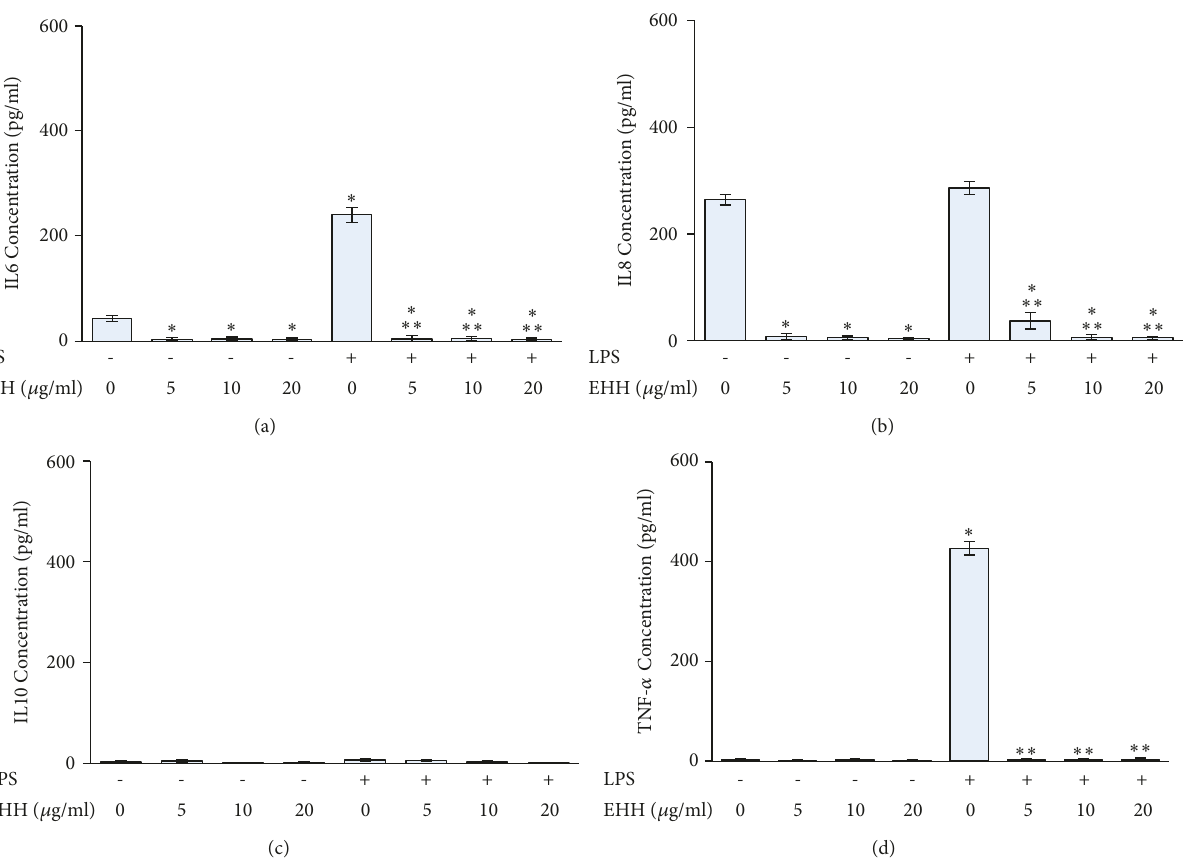
Figure 6: The effect of EHH on IL6 (a), IL8 (b), IL10 (c), and TNF- 𝛼 (d) production in PBMCs and LPS-treated PBMCs. PBMCs were separated using Ficoll-Paque density centrifugation, seeded in 12-well plates, and treated with 10 𝜇 g/ml LPS and EHH at the indicated concentration for 24 h. The levels of IL6, IL8, IL10, and TNF- 𝛼 secretion were determined using ELISA with specific antibodies to each cytokine. ∗ p < 0.05 compared to control group; ∗∗ p < 0.05 compared to LPS-treated group